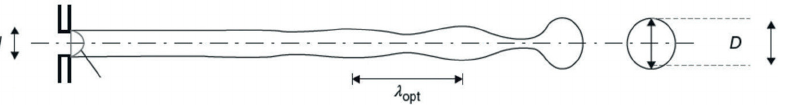
Figure 2. Schematic representation of the wave and its wavelength, d—Initial diameter of the jet; λ opt —Optimum wave ‐ length; reproduced from [15]. λ opt —Optimum wavelength; reproduced from [15].